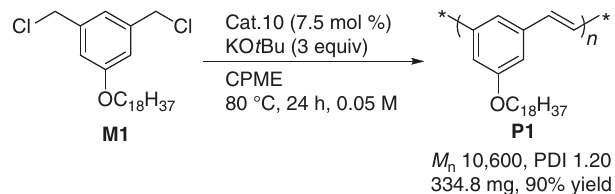
Fig. 3 Scale-up of P1 . Synthesis of P1 by BCCP